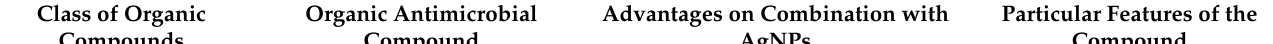
Polysaccharides